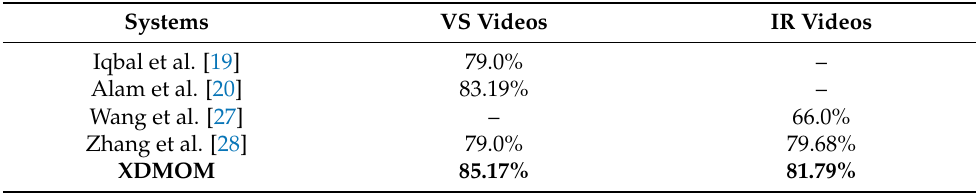
Table 9. Detection precision comparison of our system with state-of-the-art